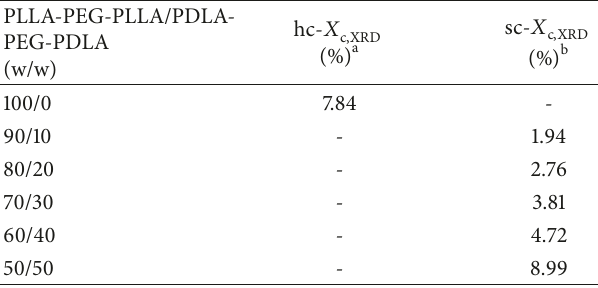
Table 3: XRD results of PLLA-PEG-PLLA/PDLA-PEG-PDLA blend